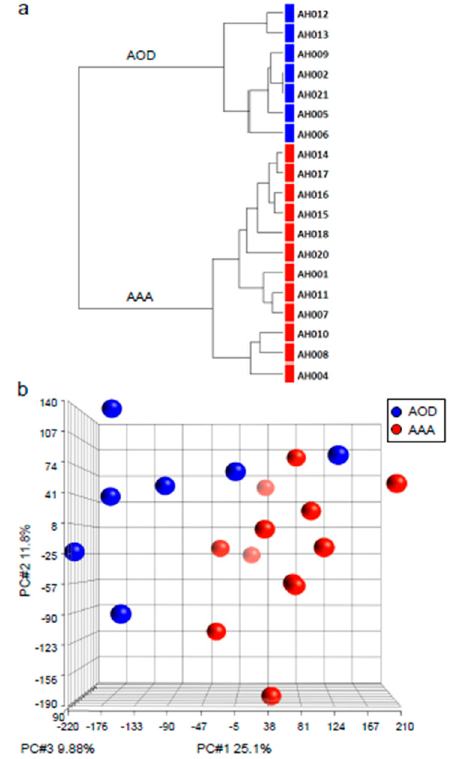
Figure 1. ( a ) Hierarchical clustering dendrogram of AAA (adominal aortic aneurysm) and AOD (arterial occlusive disease) samples. ( b ) Principal component analysis lot of AAA and AOD samples. In red the AAA patient samples, in blue the AOD patient samples. On the x, y, and z axis: PC#1 25.1%, PC#2 11.8%, PC#3 9.88%, respectively.